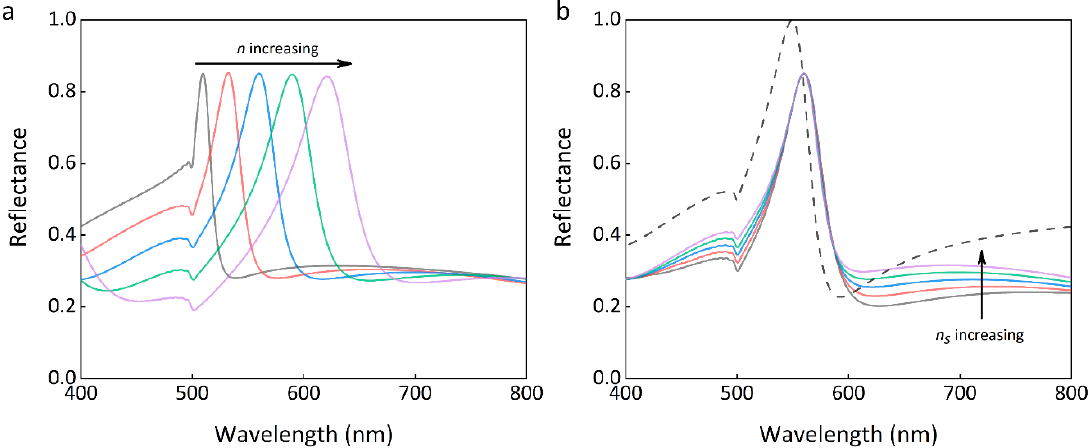
Figure 3. ( a ) The resonance wavelength shifts as the refractive index of waveguide layer n increases from 1.3 to 1.7 with a step size of 0.1. The period is fixed as P = 500 nm and thickness t = 200 nm. ( b ) The guided mode spectra for various refractive indices of the substrate n s from 1.7 to 2.1 with a step size of 0.1. The refractive index of the waveguide layer n is fixed to 1.5. Other parameters are the same as ( a ). The dashed line shows the spectrum with PEC as the grating ( P = 500 nm, t = 200 nm. n s = 1.5, n = 2).